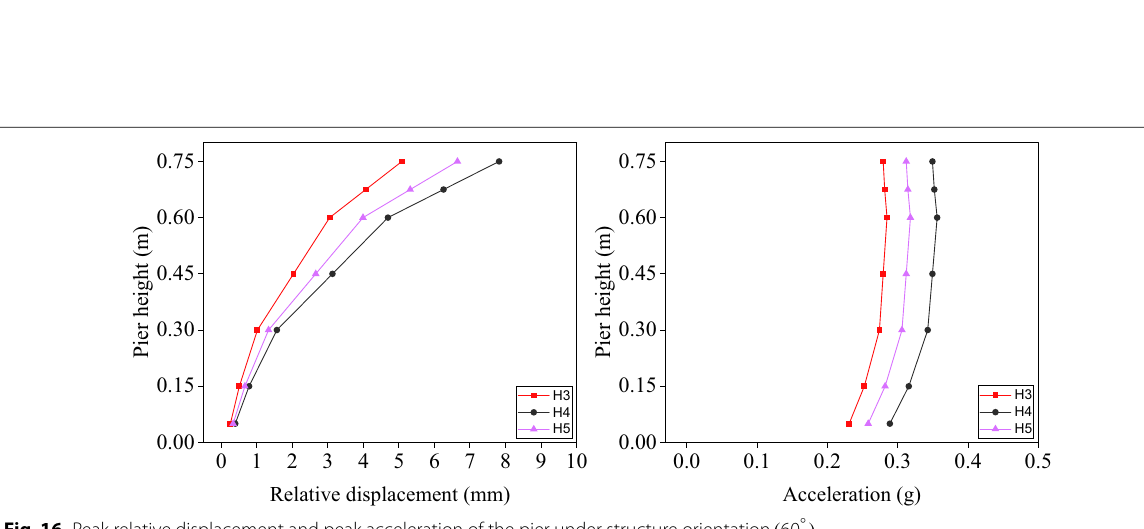
0.00 Fig. 16 Peak relative displacement and peak acceleration of the pier under structure orientation ( 60